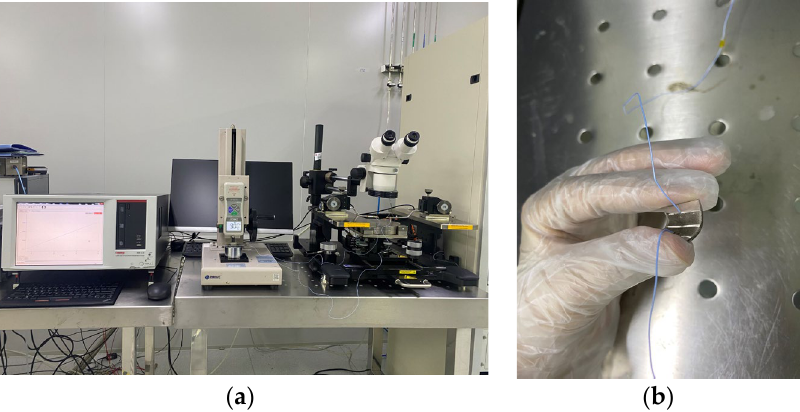
Figure 5. Images showing the physical testing of the flexible pressure sensor. ( a ) Flexible pressure sensor under 9 N pressure; ( b ) flexible pressure sensor.